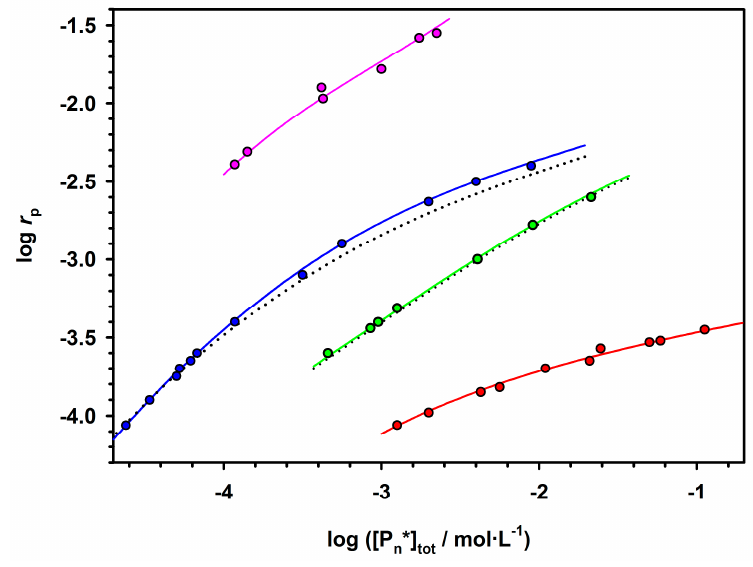
Figure 3. Green plot: The polymerization of 2-methoxystyrene with Li + ion, in toluene as a solvent, at 20 °C (the experimental data taken from [42]). Pink: An anionic polymerization of methyl methacrylate with Li + cation, in THF as a solvent, at − 65 °C (the experimental data taken from [43]). Blue: The polymerization of oxirane on − CH 2 CH 2 O − , Cs + ion pairs, in THF as a solvent, at 70 °C (the experimental data taken from [44]). Red: The polymerization of hexamethylcyclotrisiloxane (D 3 ) on − Si(CH 3 ) 2 O − , Li + ion pairs, in THF as a solvent, at 22 °C (the experimental data taken from [45]). Graph has been taken from our paper [8].